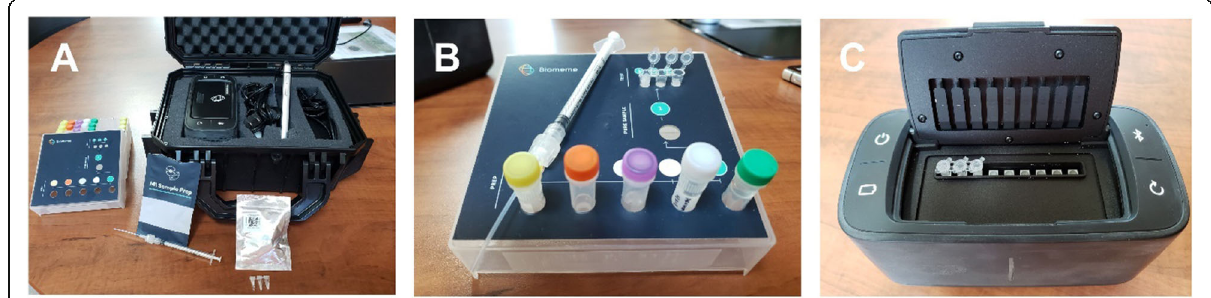
Fig. 3 Overview of the Biomeme system. a complete set-up with PCR cycler and extraction kit. b Biomeme M1 syringe-based sample prep kit. c Biomeme battery operated mobile